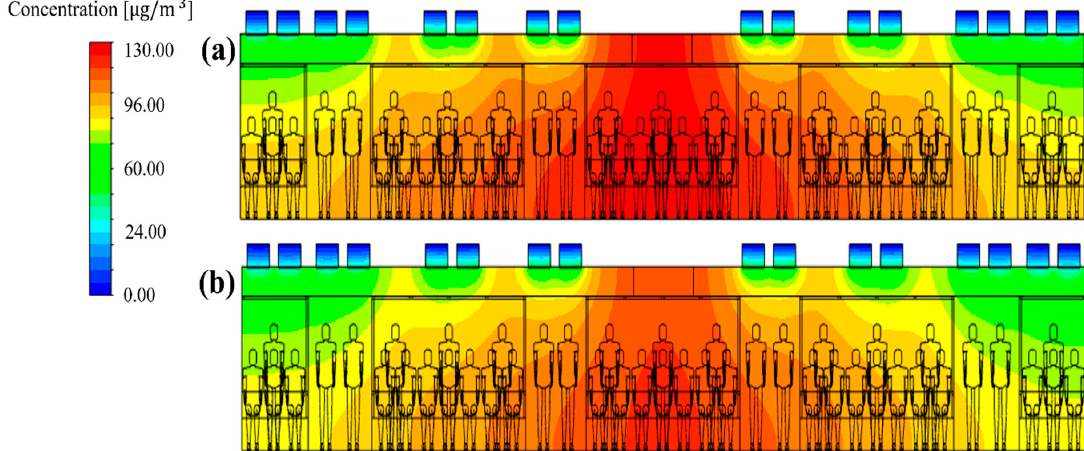
Figure 12. PM 10 concentration distribution in the subway cabin according to the total ventilation flow rate (filter efficiency of 70% and flow rate ratio of 20:20:60 applied): ( a ) 600 CMH (case 27); ( b ) 700 CMH (case 28).